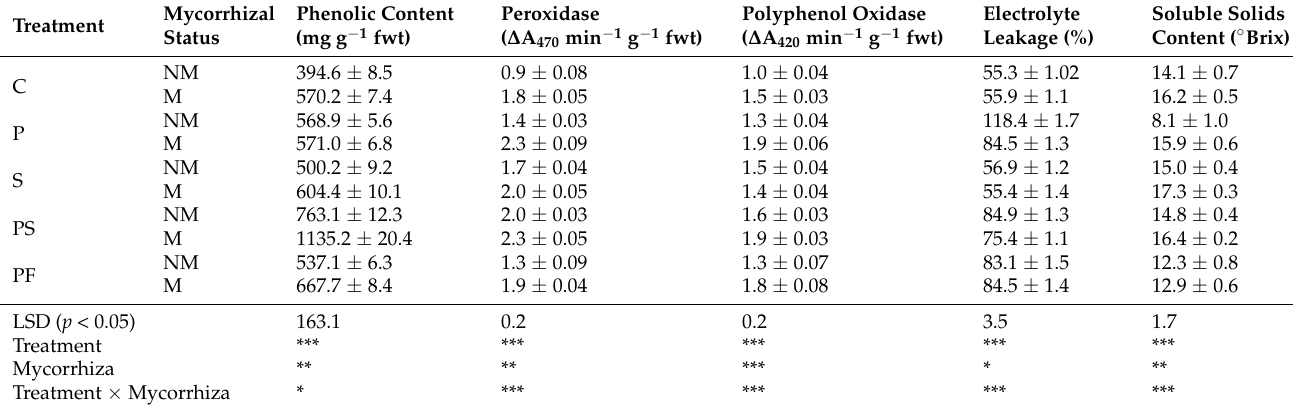
Table 5. Effects of application of S. viridosporus HH1 and/or colonization with R. irregularis on phenolic content, activity of antioxidant enzymes (30 days post planting), electrolyte leakage, and total soluble solids (50 days post planting) of pea plants (cv. Master-B) infected with Fusarium wilt a